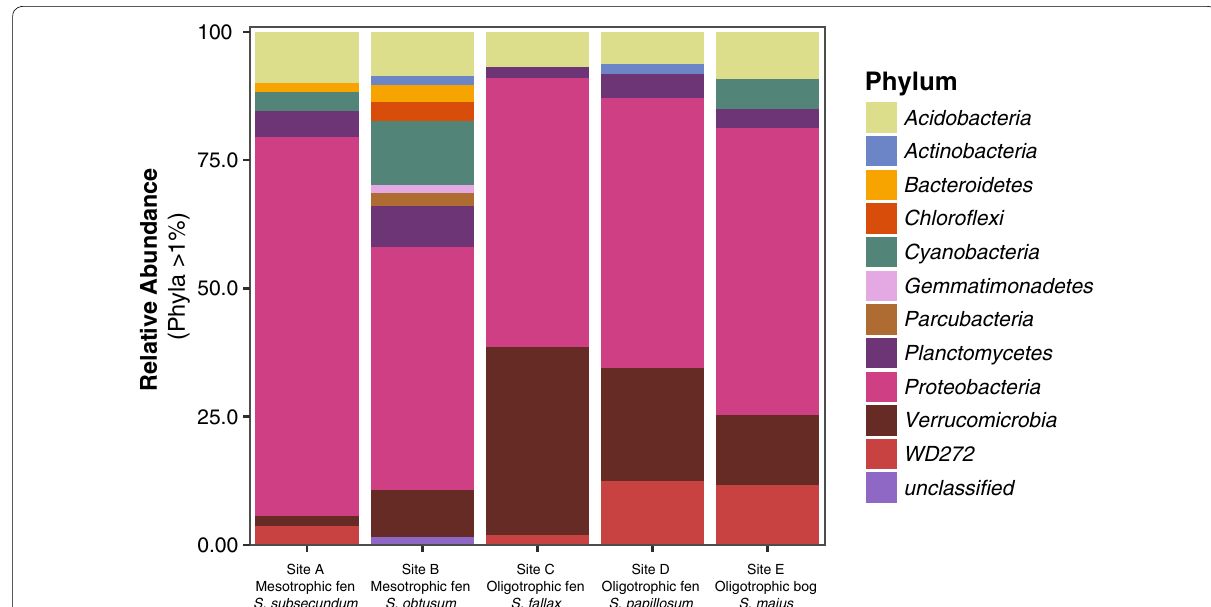
Fig. 3 Taxonomic composition (16S rRNA) of the microbial community associated with Sphagnum moss from site A–E. Bar charts represent the rela- tive abundance of the different phyla present in each site. Only phyla with a RA > 1% are